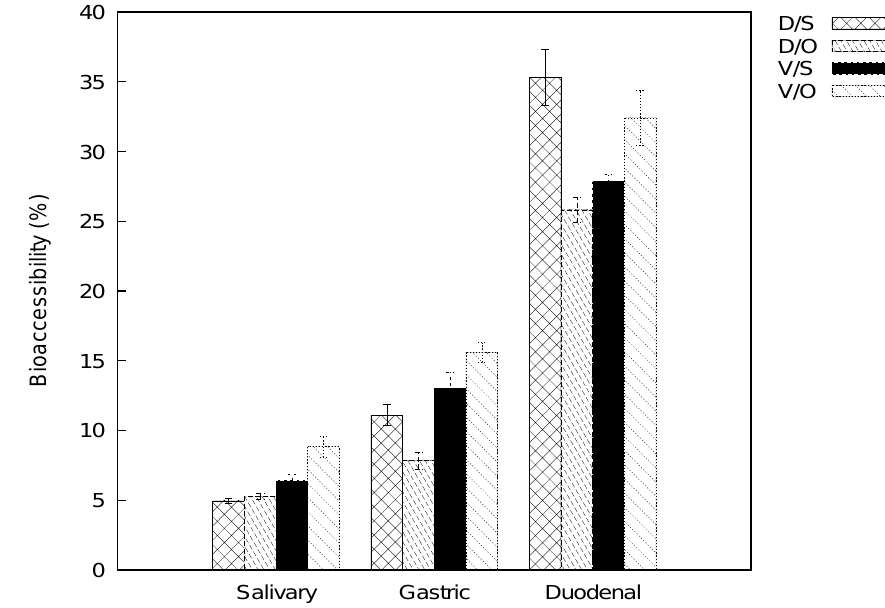
Figure 4. Bioaccessibility of β -carotene from cooked pumpkins: D/S, “Delica” steam-cooked; D/O, “Delica” oven-cooked; V/S, “Violina” steam-cooked; V/O, “Violina”